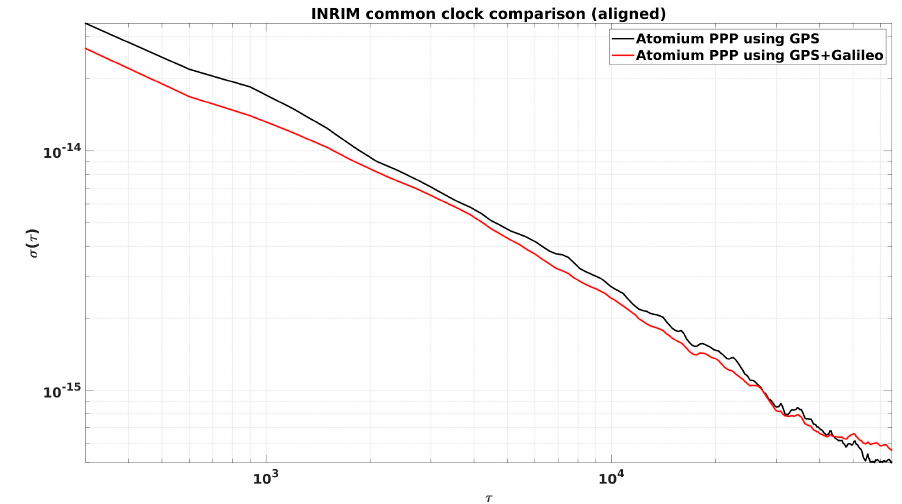
Figure 4. ADEVs for the CCD GPS-only and GPS + Galileo PPP results in the Italian National Metrology Institute (INRIM).